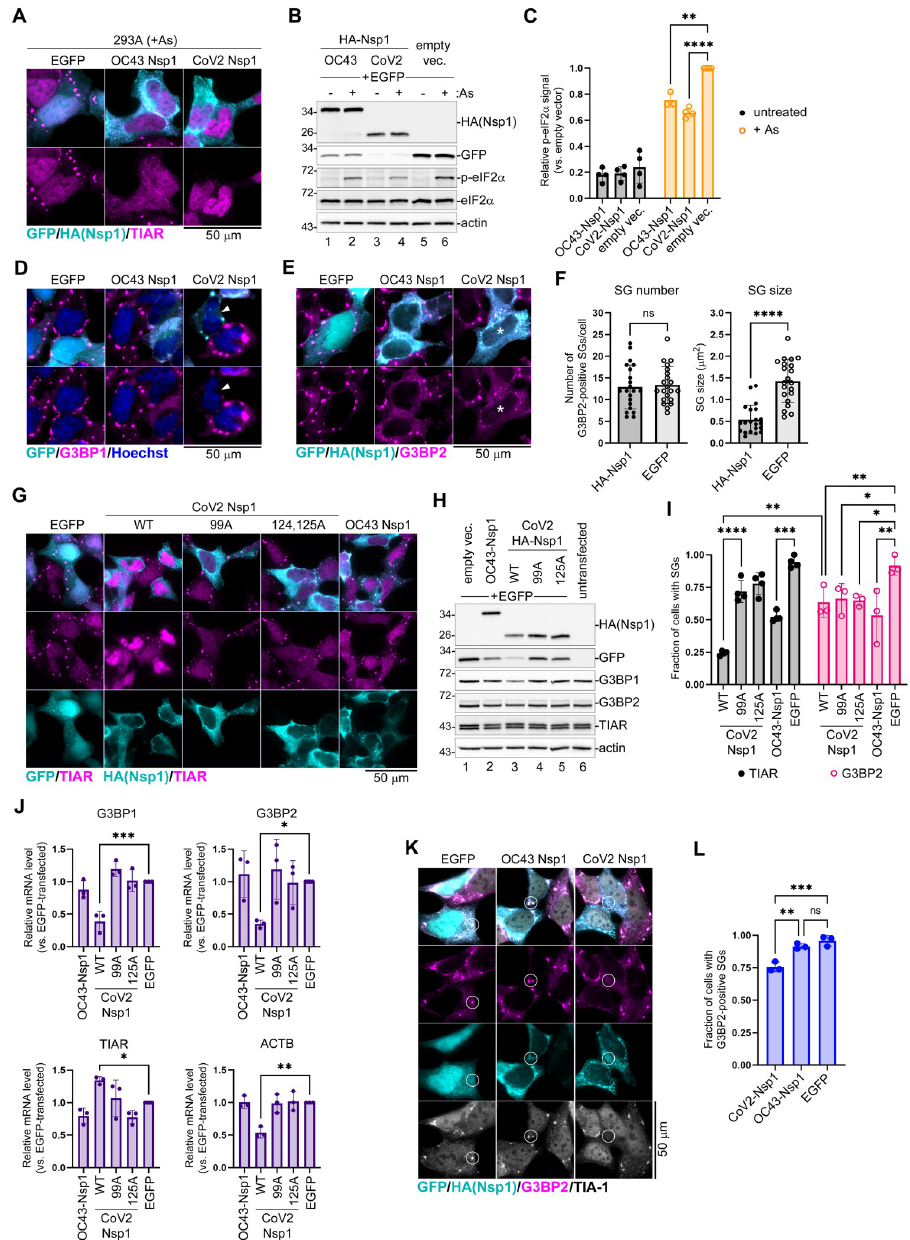
Fig 5. Nsp1 inhibits eIF2 α phosphorylation and SG formation. (A) 293A cells were transiently transfected with the indicated HA-tagged Nsp1 expression constructs or EGFP control. At 24 h post-transfection cells were treated with sodium arsenite (+ As) and SG formation analysed by immunofluorescence microscopy staining for TIAR (magenta). GFP signal in control cells and HA-tagged Nsp1 signal are shown in teal. Scale bar = 50 μ m. (B) Whole cell lysates from cells treated as in A with or without As were analysed by western blot. (C) Phospho-eIF2 α band intensity normalized to total eIF2 α was quantified from B and plotted relative to phospho-eIF2 α level in EGFP control cells treated with As. Each data point represents independent biological replicate (N � 3). Error bars = standard deviation. Two-way ANOVA and Tukey multiple comparisons tests were done to determine statistical significance ( ���� , p -value < 0.0001; ��� , p-value < 0.001; �� , p-value < 0.01). (D) Immunofluorescence microscopy analysis of cells expressing the indicated EGFP-tagged Nsp1 constructs or EGFP control. SG formation was visualized by staining for G3BP1 (magenta). GFP signal is shown in teal. Arrowhead indicates a representative cell with low G3BP1 signal. Scale bar = 50 μ m. (E) Immunofluorescence microscopy analysis of cells expressing the indicated HA-tagged Nsp1 constructs or EGFP control. SG formation was visualized by staining for G3BP2 (magenta). GFP signal in control cells and HA-tagged Nsp1 signal are shown in teal. Asterisks indicates a representative CoV2 Nsp1 expressing cell